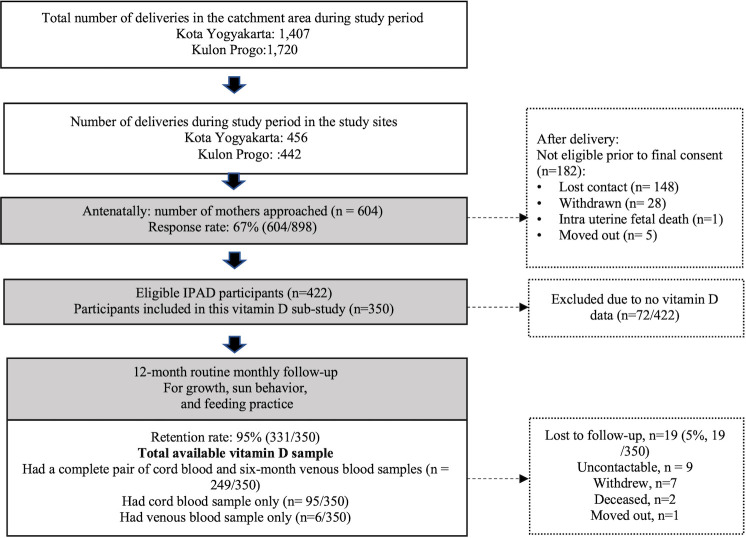
Flow diagram depicts sample collection for vitamin D measurement and inclusion in the final analyses.